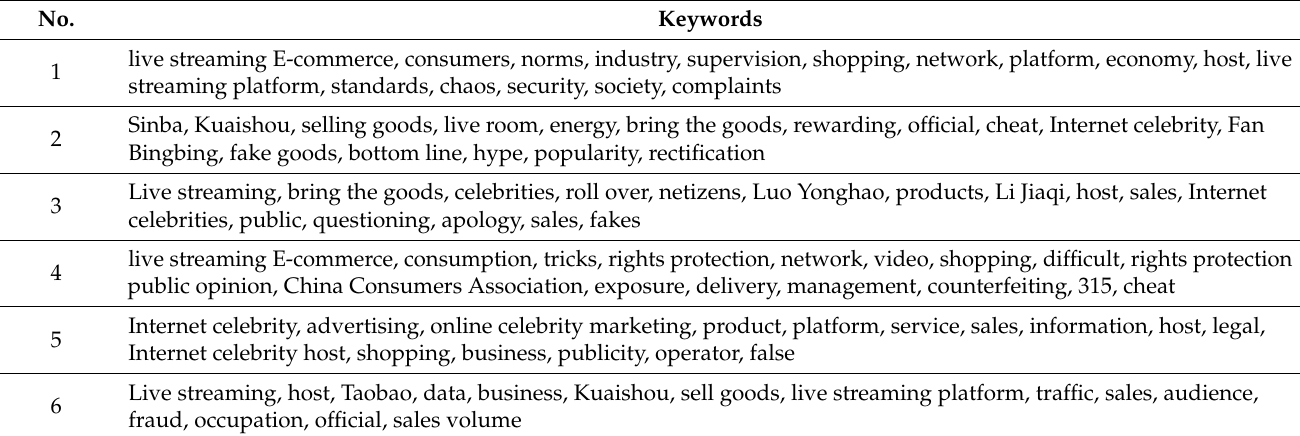
Table 6. Topic extraction of comment data under LDA models topics 4 and